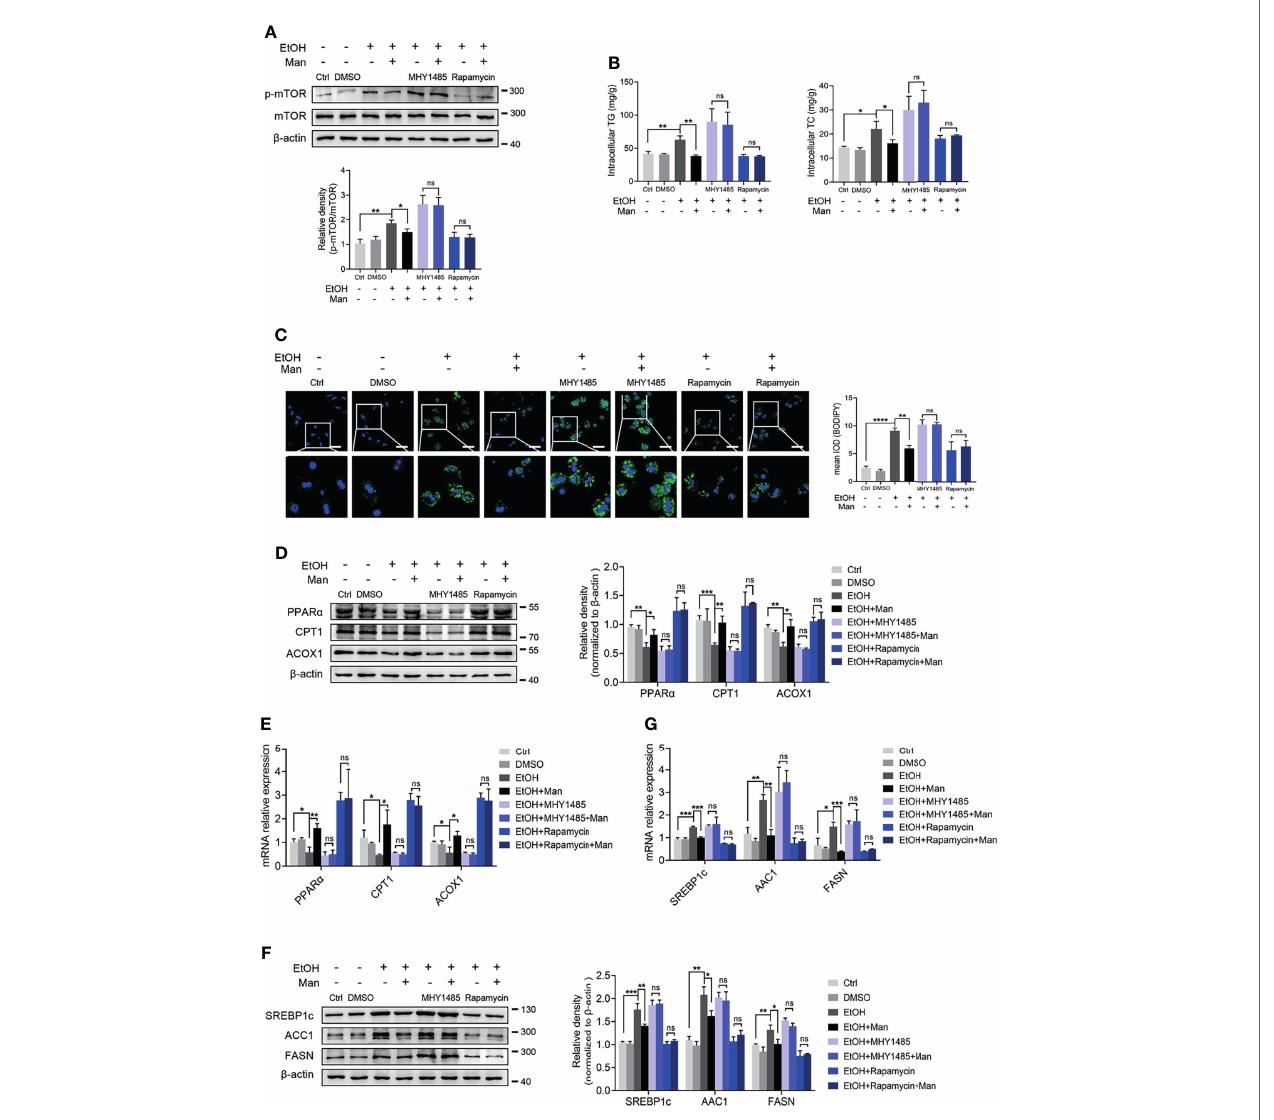
FIGURE 6 | mTOR activation is involved in the mannose-mediated improvement of ethanol-induced lipid accumulation in PMHs. PMHs were pretreated with MHY1485 (mTOR agonist, 10 m M) or Rapamycin (mTOR inhibitor, 10 nM) for 2 h (DMSO as control), ahead of treatment with 200 mM ethanol (EtOH) and 5 mM mannose (Man) or culture medium (Ctrl) for 24 h (n = 3). (A) Western blotting was used to evaluate the p-mTOR expression in cultured PMHs. (B) Cellular content of TG and TC levels were determined. (C) The intracellular levels of neutral lipids were evaluated by BODIPY 493/503 staining assay. (D – G) Western blotting and qRT- PCR analysis for protein and mRNA levels of lipid-regulating genes in PMHs. Scale bars = 50 m m. Data are expressed as the mean ± SEM of three independent experiments. * p < 0.05, ** p < 0.01, *** p < 0.001, **** p < 0.0001, ns, not signi fi cant, unpaired two-tailed t